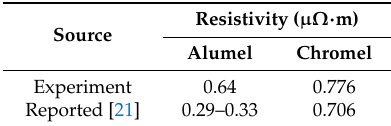
Figure 7. Cross sectional micrographs for optimized tracks: ( a ) chromel; ( b ) alumel. Table 2. Experimental and nominal resistivity of type K thermocouple.